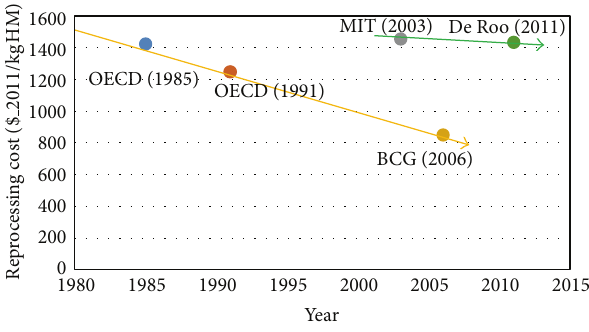
Figure 2: Reprocessing costs trend